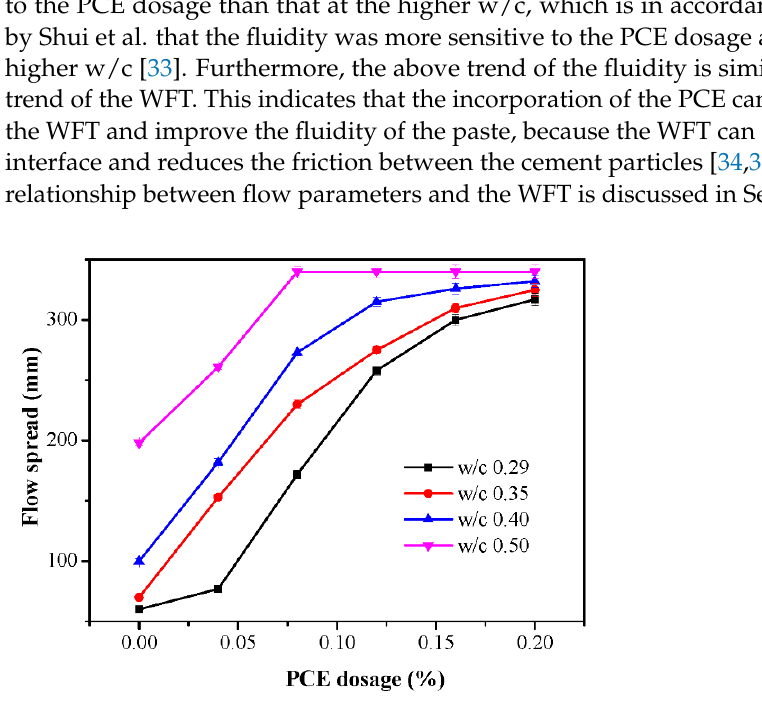
Figure 6. Variations of the yield stress and apparent viscosity with w/c for different PCE contents.